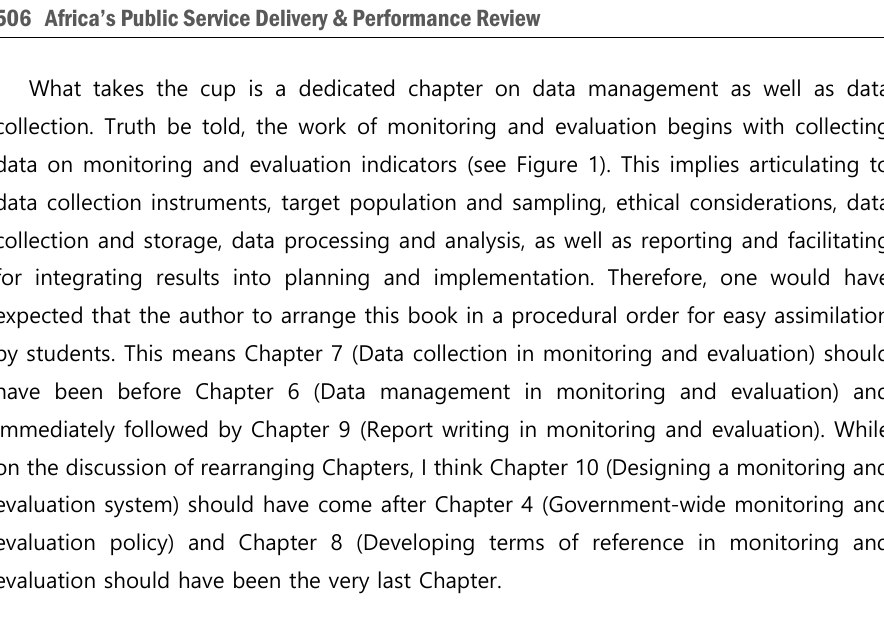
Figure 1: Illustrating the relationship between monitoring and evaluation and its components as well as its